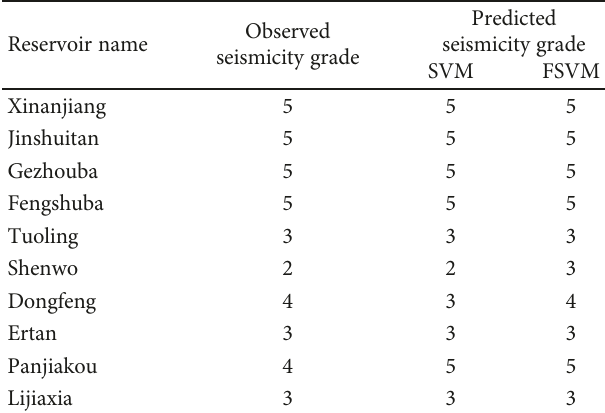
Table 13: Prediction results of RTE with group 2.